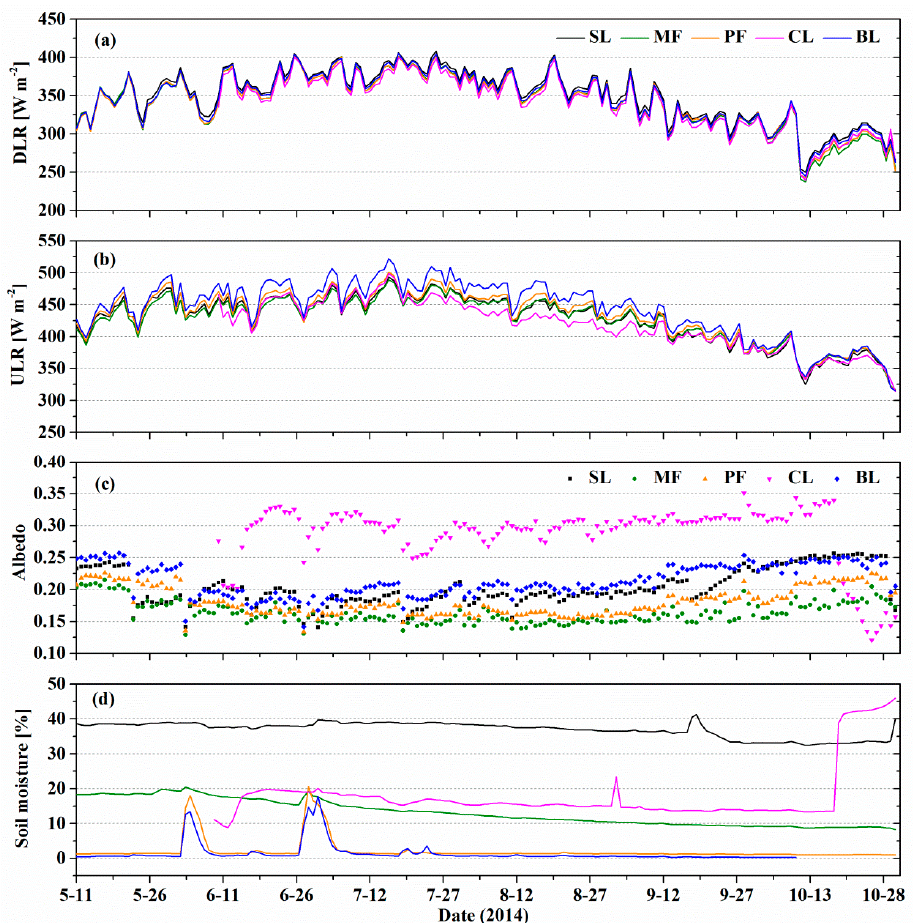
Figure 7. Comparisons of daily-averaged ( a ) downward longwave radiation (DLR), ( b ) upward longwave radiation (ULR), ( c ) albedo, and ( d ) volumetric water content of soil at 0.02 m depth between the five stations. In ( c ) only daytime data (8:00–19:30 BST) are selected. The legend is consistent to Figure 6.